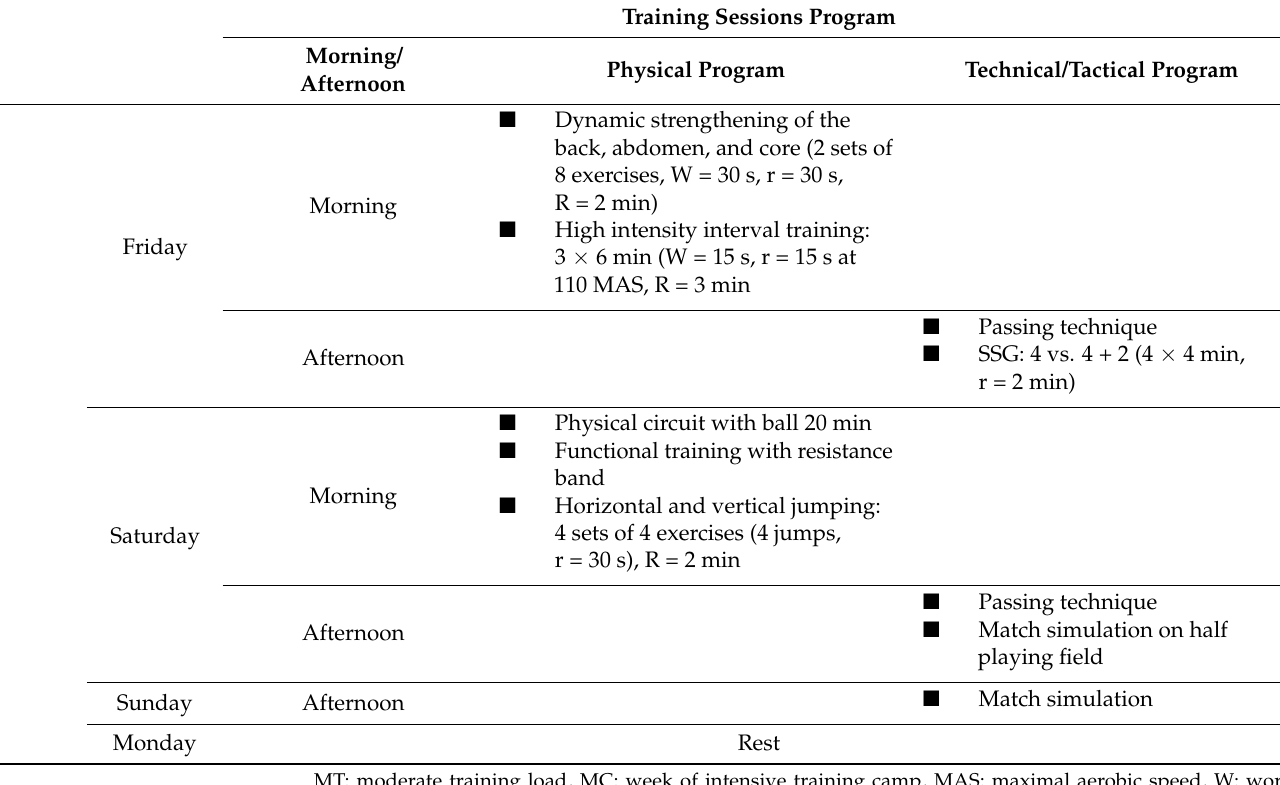
Training Sessions Program